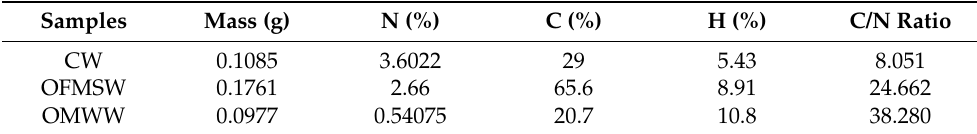
Table 3. Ultimate analyses of the substrate (wet basis).